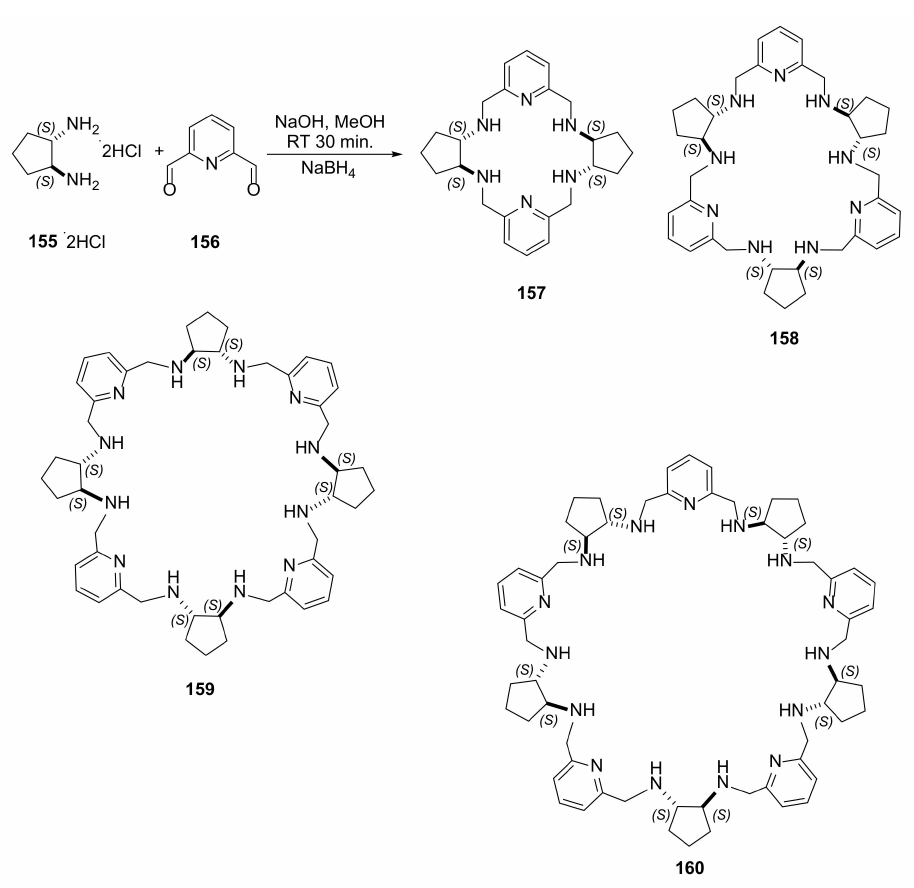
Figure 32. Nontemplated synthesis of the mixture of [2 + 2], [3 + 3], [4 + 4], and [5 + 5] polymimine macrocycle mixtures followed by their reduction.